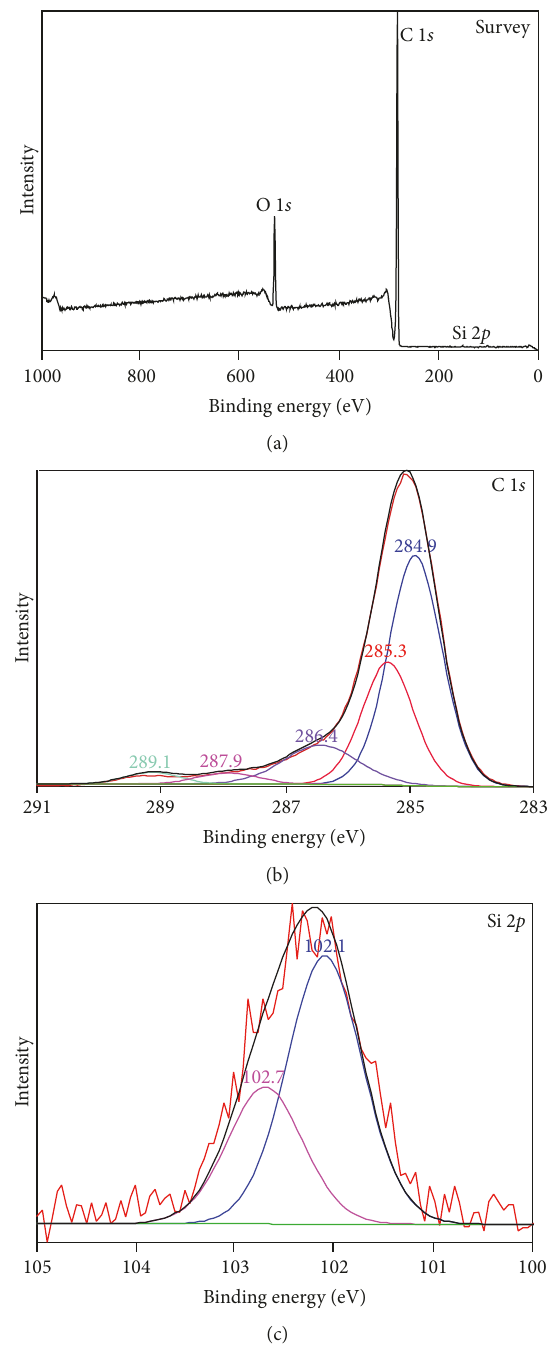
Figure 7: XPS analysis of EF PE . ((a) survey scan of the sample; (b) peak fitting of the C 1 s ; and (c) peak fitting of the Si 2 p .)